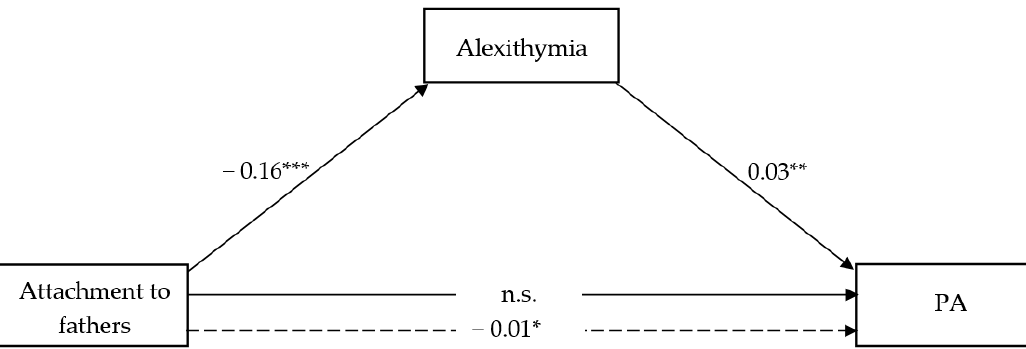
Figure 4. Attachment to father and PA. * p < 0.05; ** p < 0.01; *** p < 0.000; ns = not significant; dotted line = Total effect.